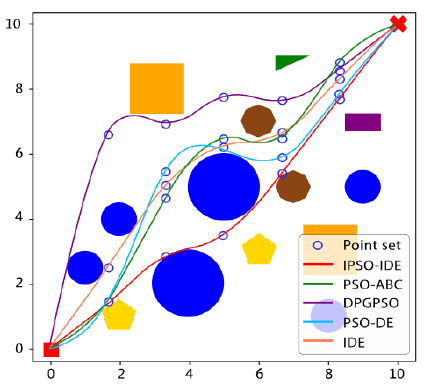
Figure 11. Optimal path results based on different algorithms in environment 3.